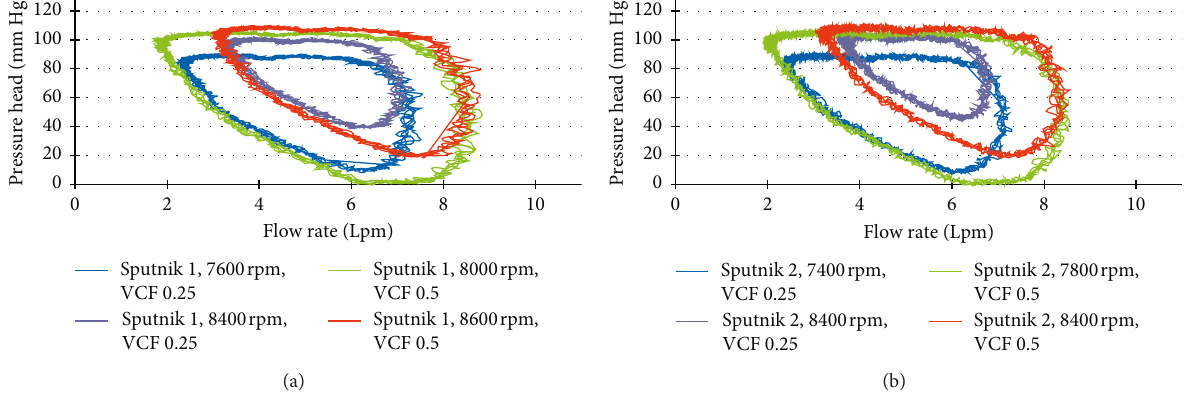
Figure 11: Dynamic pressure head-flow rate curves of Sputnik 1 and Sputnik 2 LVADs supporting LV in the moderate and the congestive heart failure state at the pump speeds of partial-to-full support change (blue and red) and full support state (green and purple).